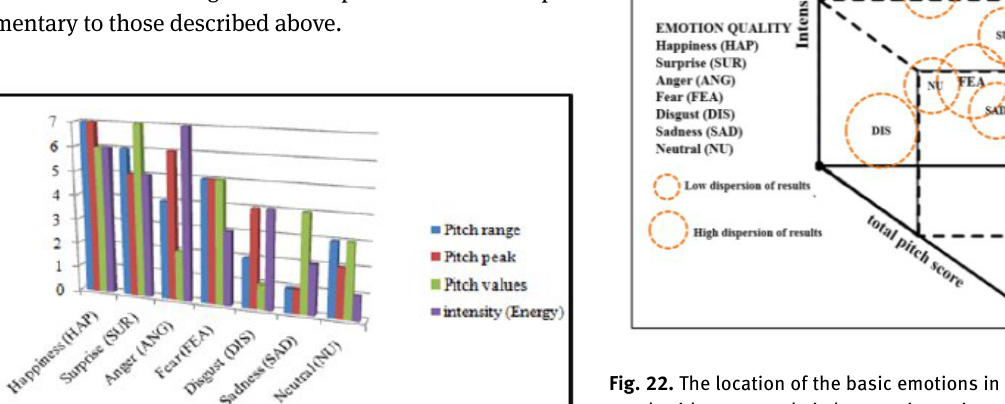
Fig. 22. The location of the basic emotions in the three-dimensional graph with axes: total pitch score, intensity and speech